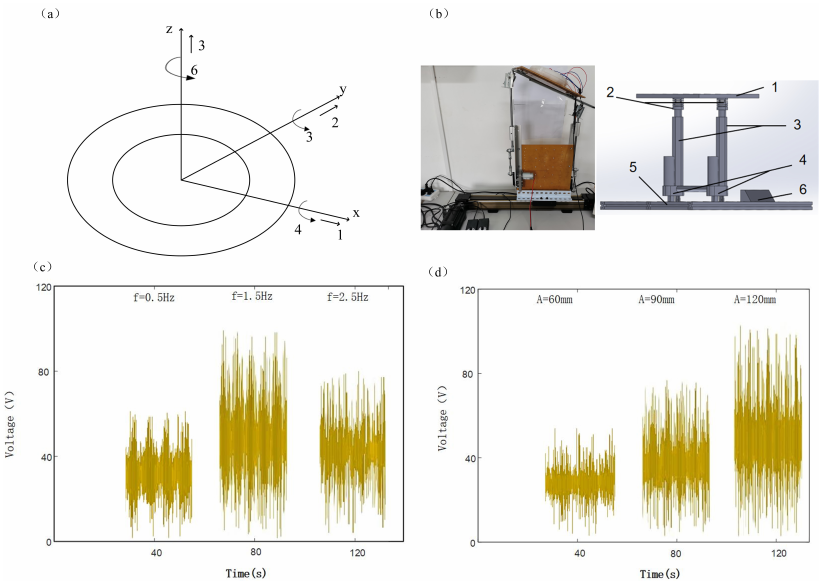
Figure 4. ( a ) Six degrees of freedom of the A-TENG under wave force (1. surge, 2. sway, 3. heave, 4. roll, 5. pitch, 6. yaw). ( b ) Schematic diagram of experimental platform and platform structure (1. glass platform, 2. connecting structure, 3. two electric push rods, 4. push rod base, 5. linear module slide table and slide rail, 6. master control platform). ( c , d ) Open-circuit voltage at different wave frequencies and different wave amplitudes under heave degrees of